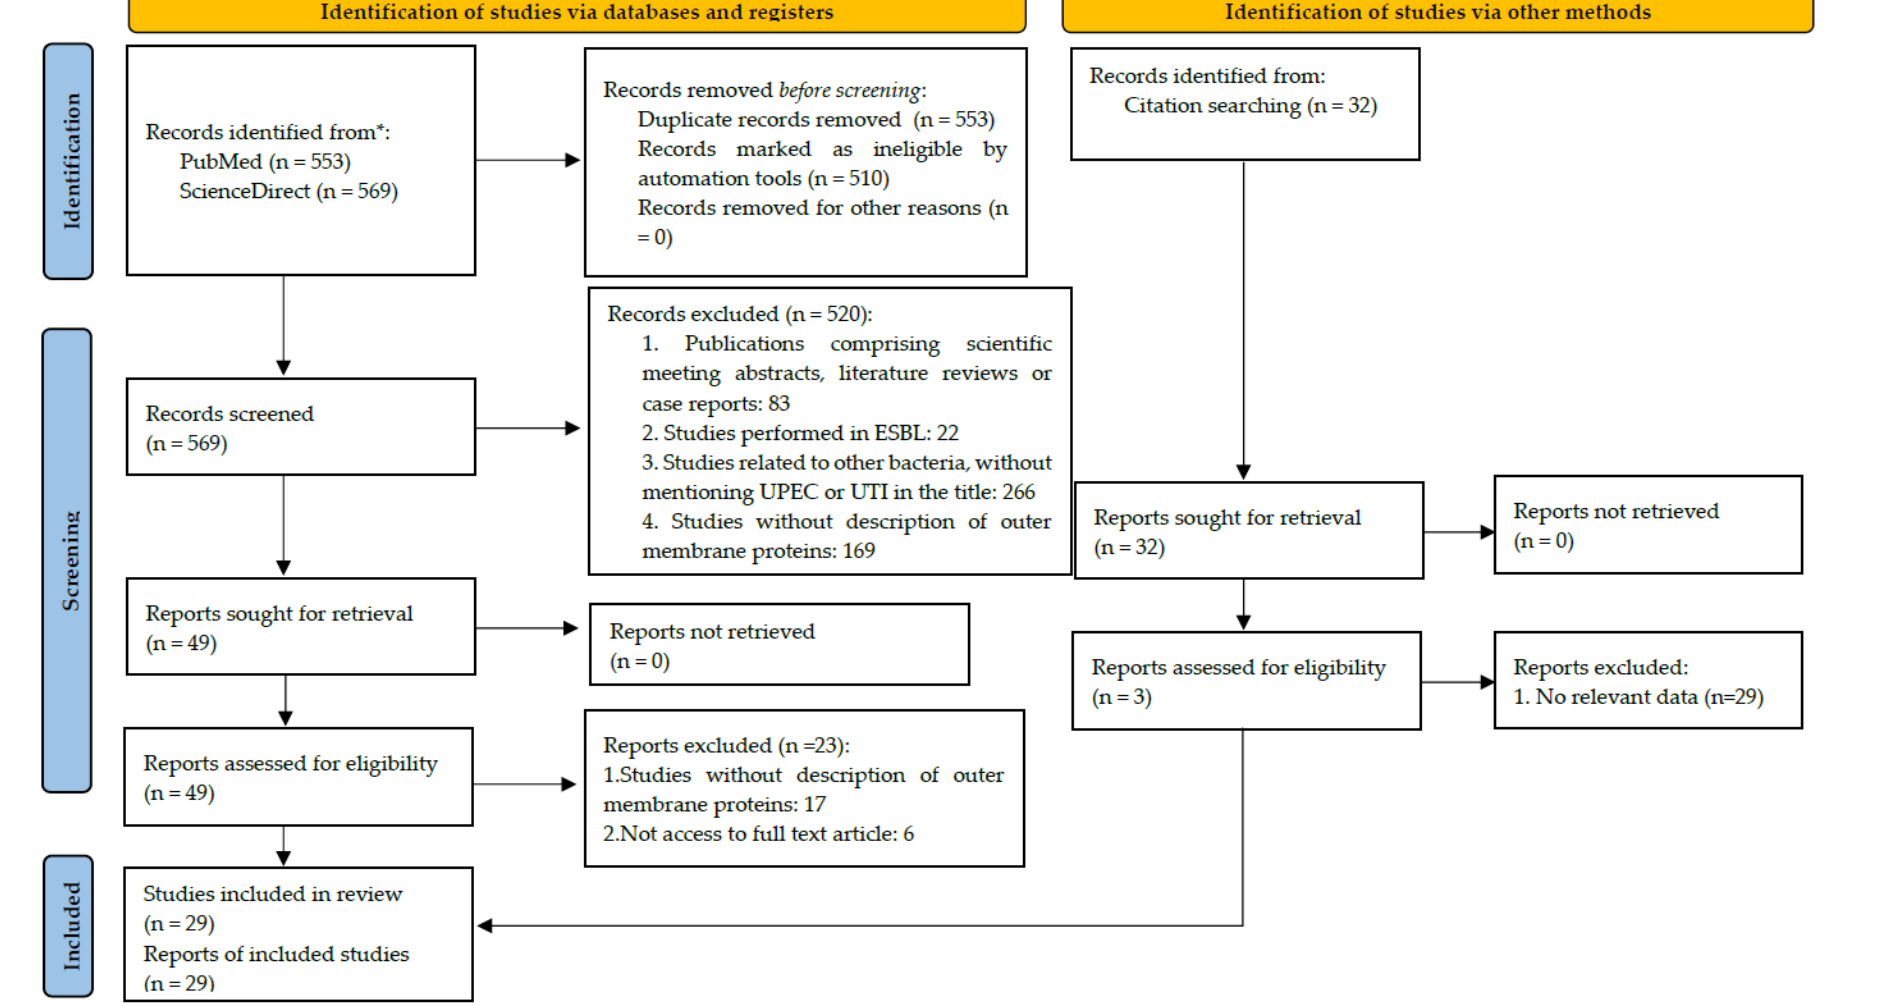
Figure 1. PRISMA 2020 flow diagram. Adapted from [19]. * Consider, if feasible to do so, reporting the number of records indenified from each database or register searched (rather than the total number across all databases/registers).